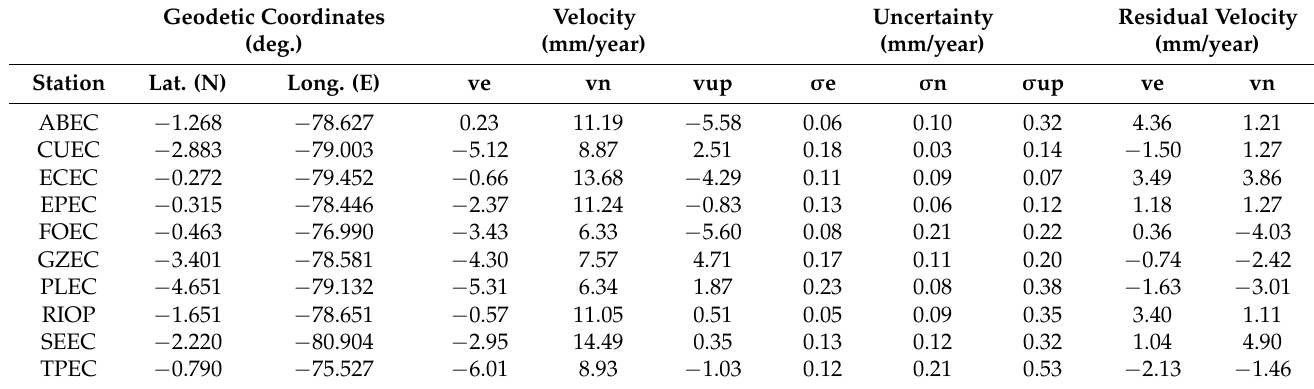
Table 2. Absolute velocities in the north and east components from the GPS position time series in the IGS14 frame. Residual velocities concerning the fixed reference frame of South America plate.